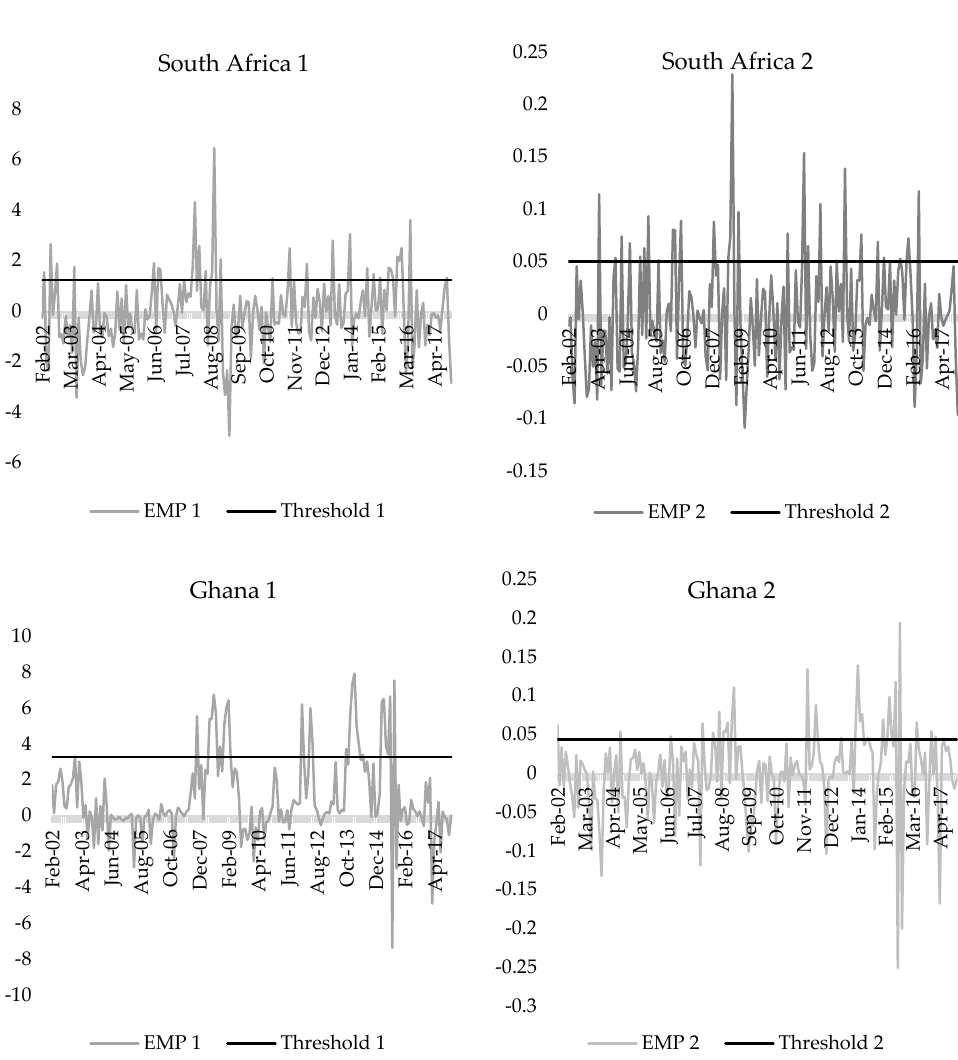
Figure 1. Exchange rate crises episodes in South Africa and Ghana (2002–2017). Source: Authors’ Construction.